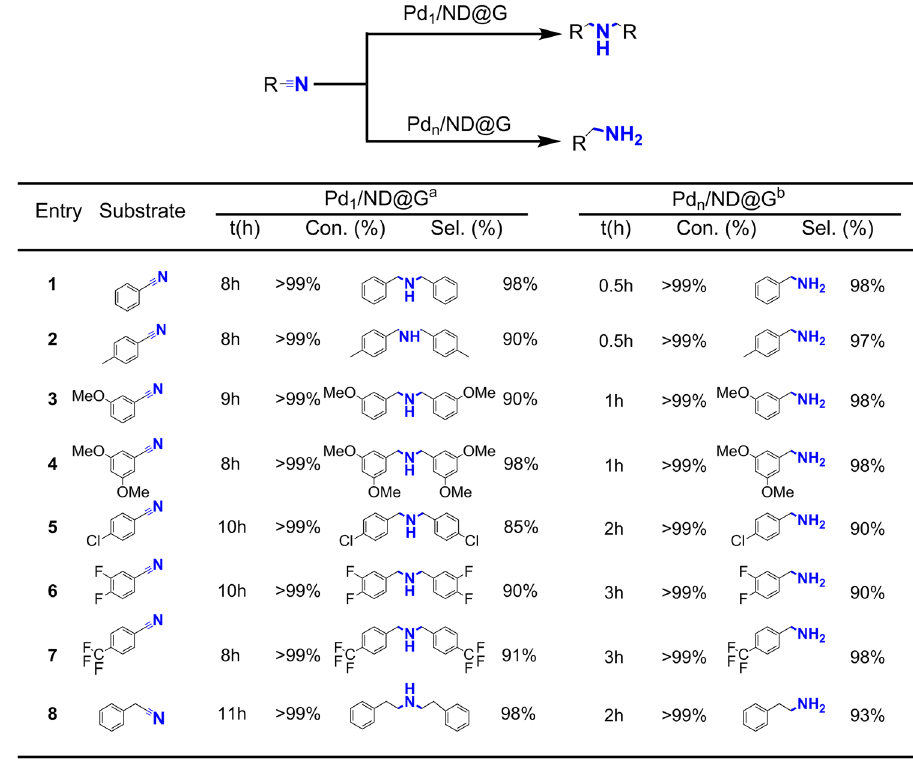
Fig. 3 Substrate extension. Catalytic performance of Pd 1 /ND@G and Pd n /ND@G catalyst in transfer hydrogenation of different substituted